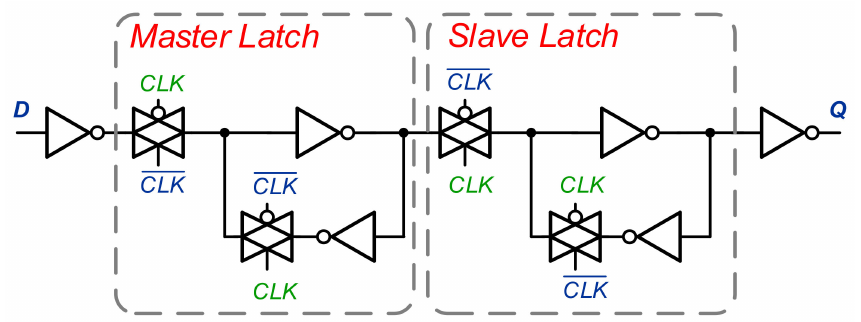
Figure 1. Schematic diagram of MS-DFF.